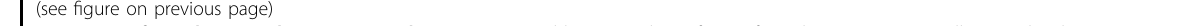
SKP2 is another important oncogene and CSC reg- ulator, as high SKP2 expression predicts poor prognosis in multiple cancers including breast cancer 28 . Furthermore,